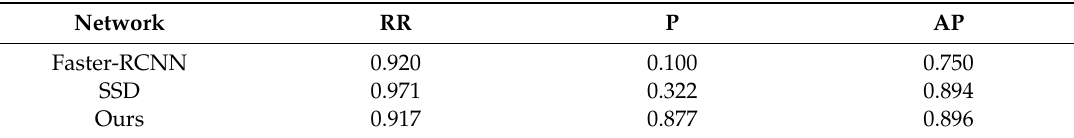
Table 1. The performance of bridges detection by different networks.